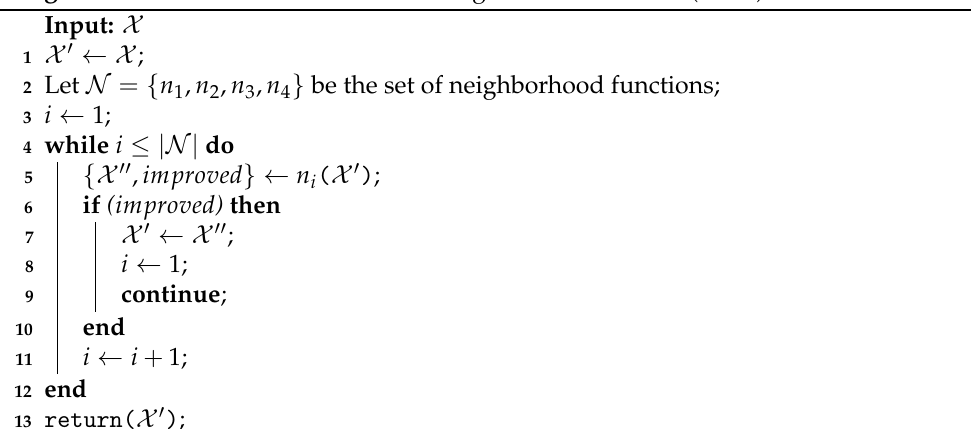
Algorithm 5: Structure of the variable neighborhood descent (VND)